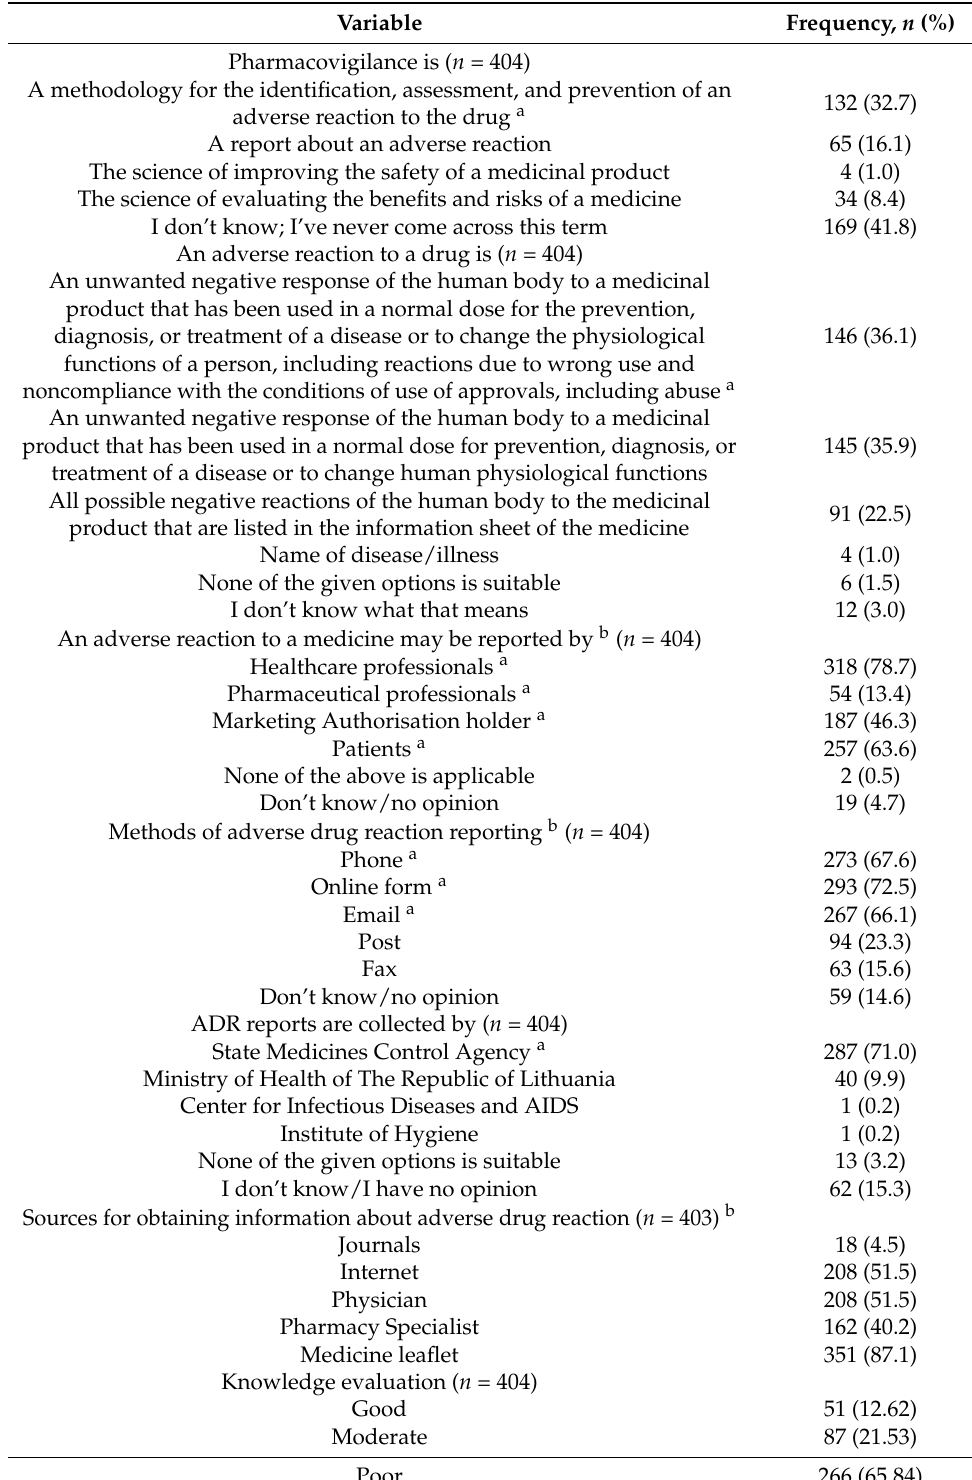
Table 2. Patients’ knowledge of pharmacovigilance and adverse drug reaction